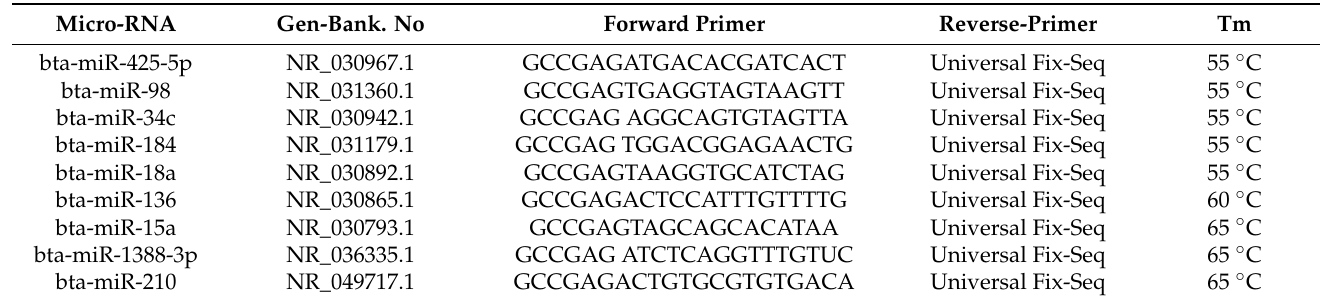
Table 1. The miRNAs forward primers were used in the RTq-PCR experiments.